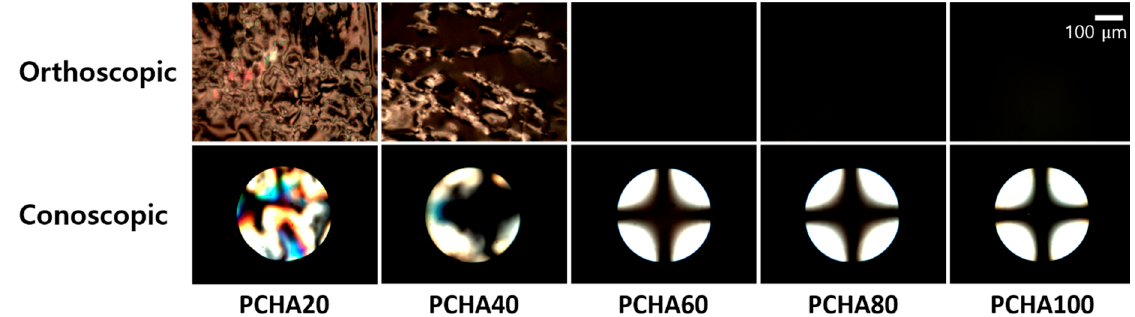
Figure 6. Orthoscopic and Conoscopic polarized optical microscopy (POM) images of the LC cells made from PCHA# (PCHA20, PCHA40, PCHA60, PCHA80, and PCHA100) films; scale bar: 100 μ m, all scale bars are the same.